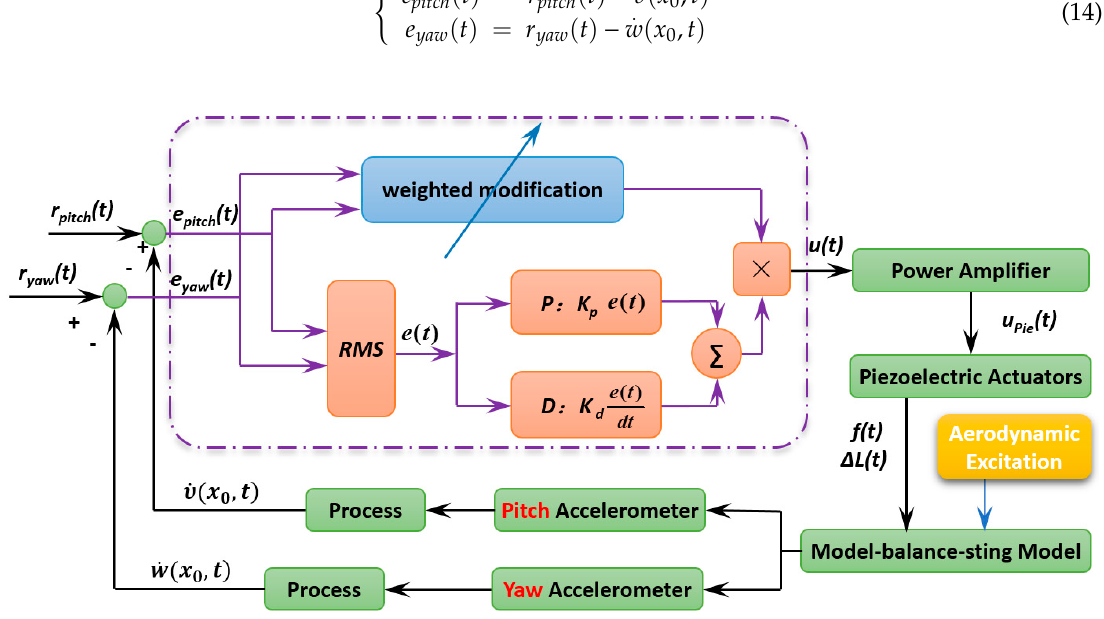
Figure 3. Schematic of control system.